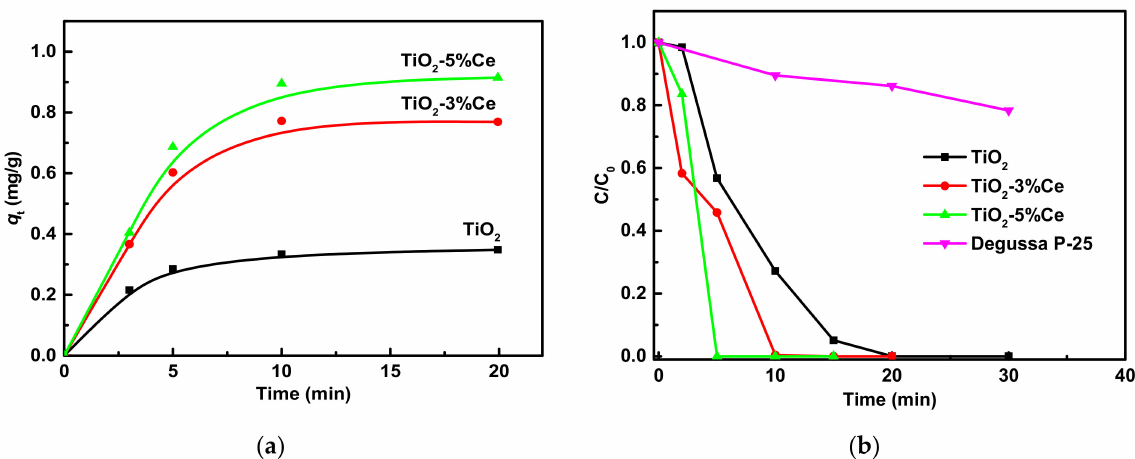
Figure 1. Kinetic curves of rhodamine B adsorption by fibrous photocatalysts at 25 ◦ C ( a ) and photocatalytic degradation of the dye under UV irradiation ( b ).